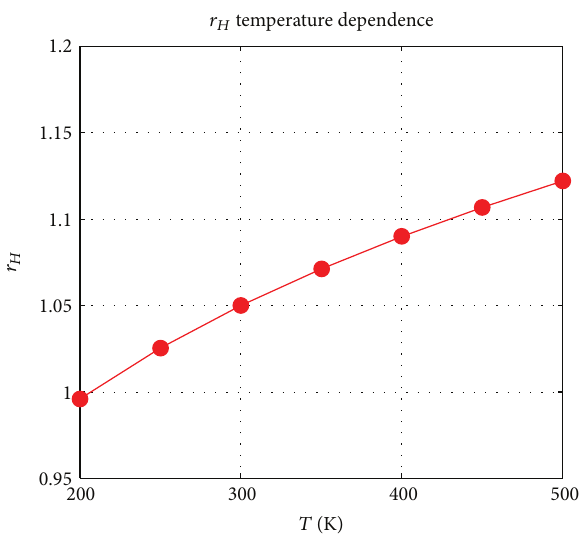
Figure 8: The Hall factor temperature